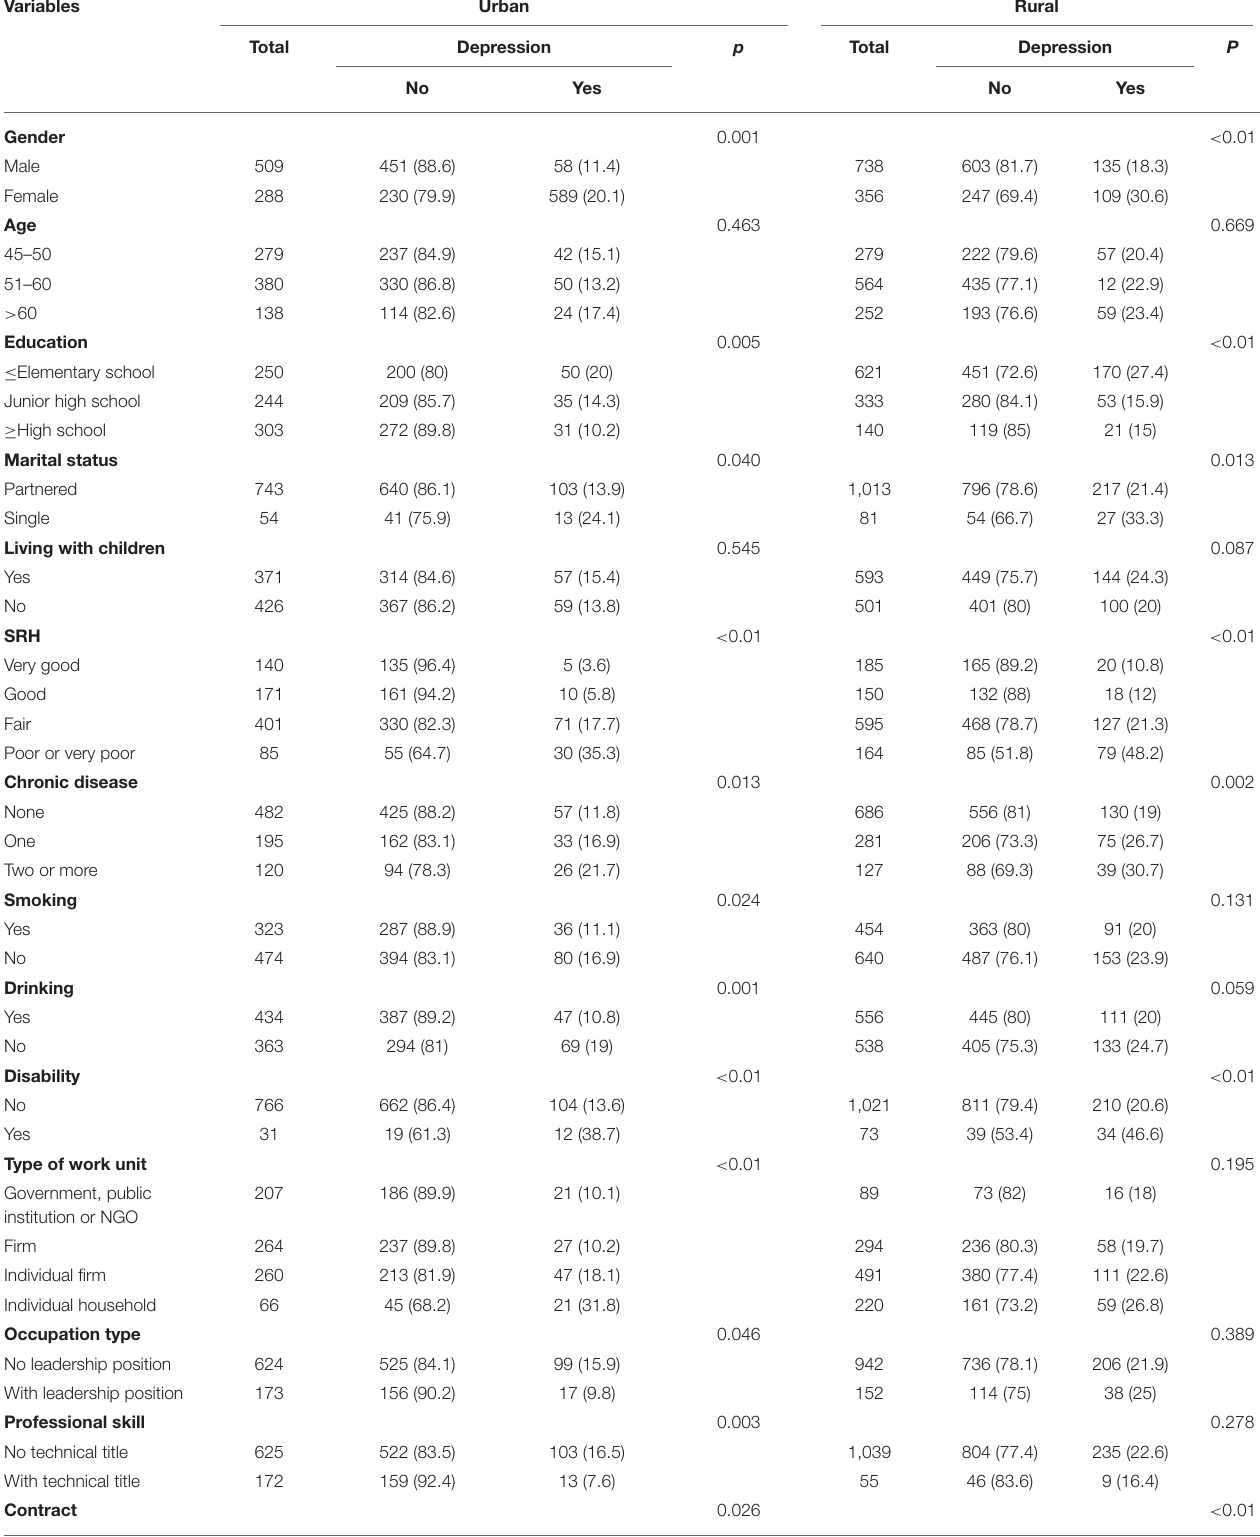
TABLE 1 | Sample characteristics and univariate analysis